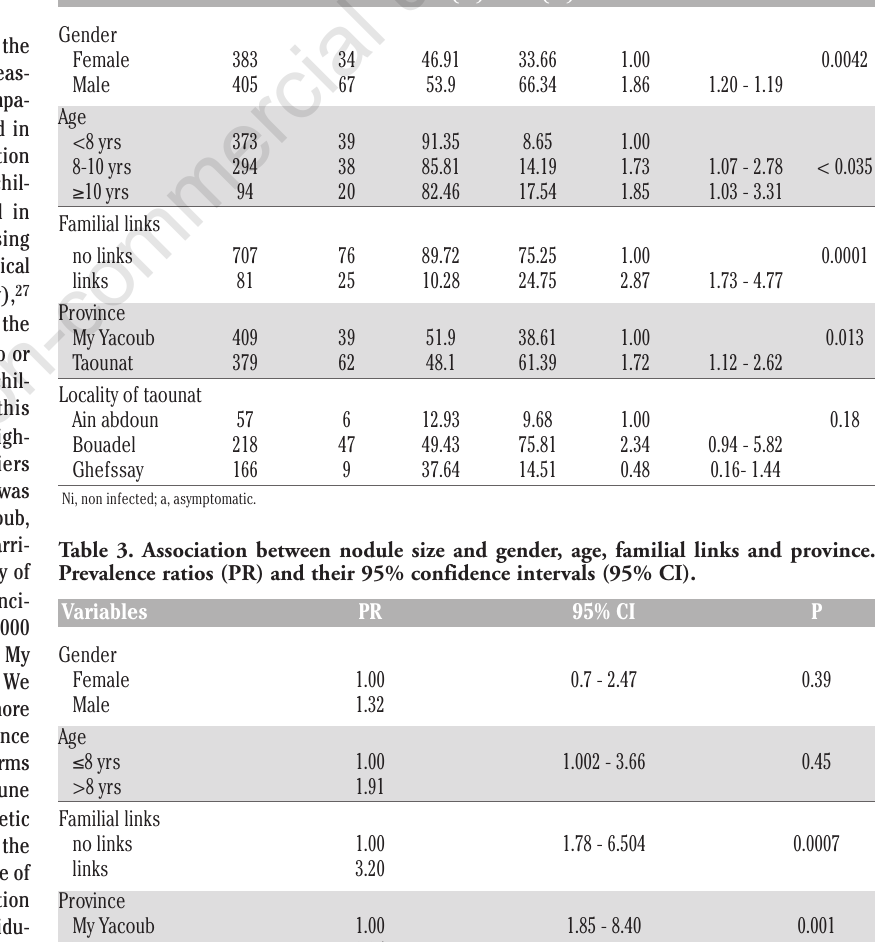
Table 2. Number (N), percentage (P) and crude prevalence ratios (PR), and their 95% confidence intervals (95% CI) for the association between result of Montenegro skin test and gender, age, familial links, provinces and locality in two endemic areas of L. infan- tum infection in northern Morocco, 2010. Variables